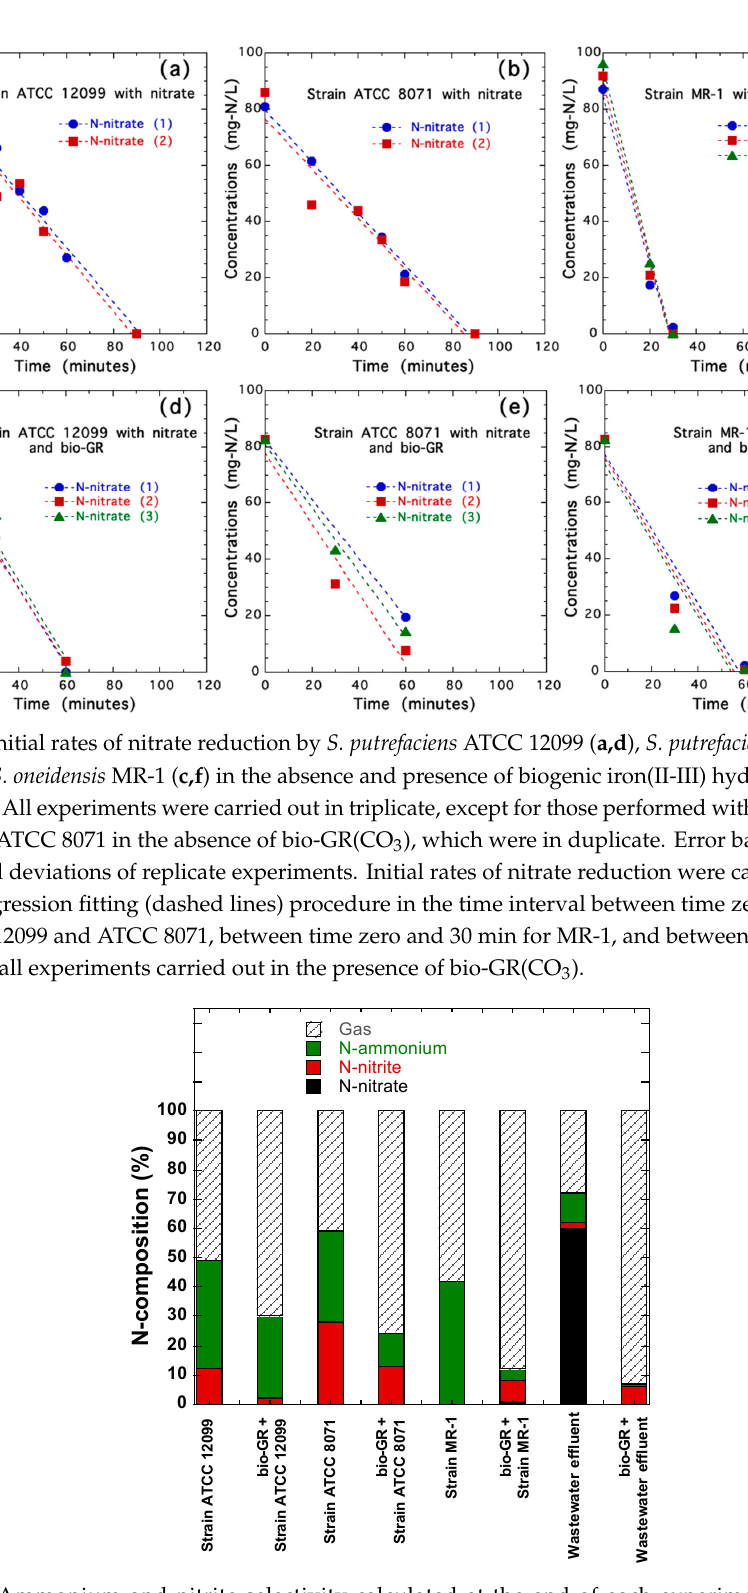
Figure 6. Ammonium and nitrite selectivity calculated at the end of each experiment performed with S. putrefaciens ATCC 12099, S. putrefaciens ATCC 8071, S. oneidensis MR-1 or with a native wastewater-denitrifying consortium after addition of nitrate ions in the absence or presence of bio-GR(CO 3 ). Table 3. Dissolved nitrogen speciation during bacterial nitrate and nitrite reduction in the presence or absence of biogenic iron (II-III) hydroxycarbonate green rust, referred to as “bio-GR(CO 3 )”. Experiments Performed with Nitrate in the Starting Solution